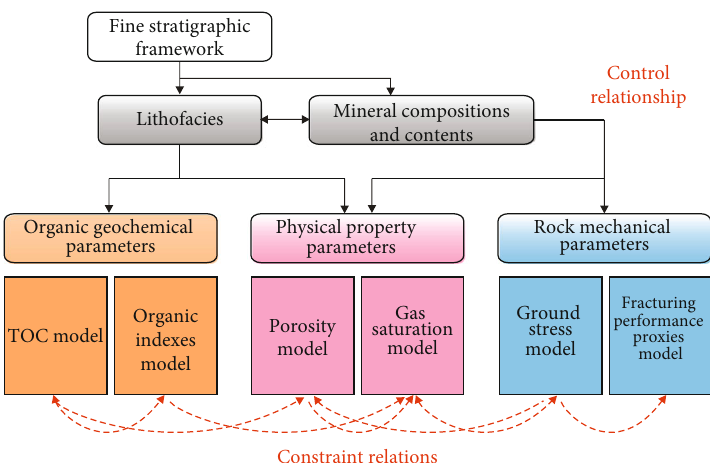
Figure 8: Constrained relationships among matrix properties of shale reservoirs. The lithofacies and mineral contents play a role in an overall control to other parameters (e.g., TOC, porosity, and mechanical parameters) which have di ff erent degrees of mutual restraint among each other.